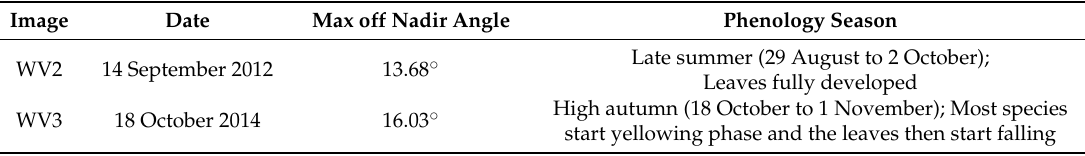
Table 1. WV2 /WV3 imagery and relevant phenological information for the study areas.